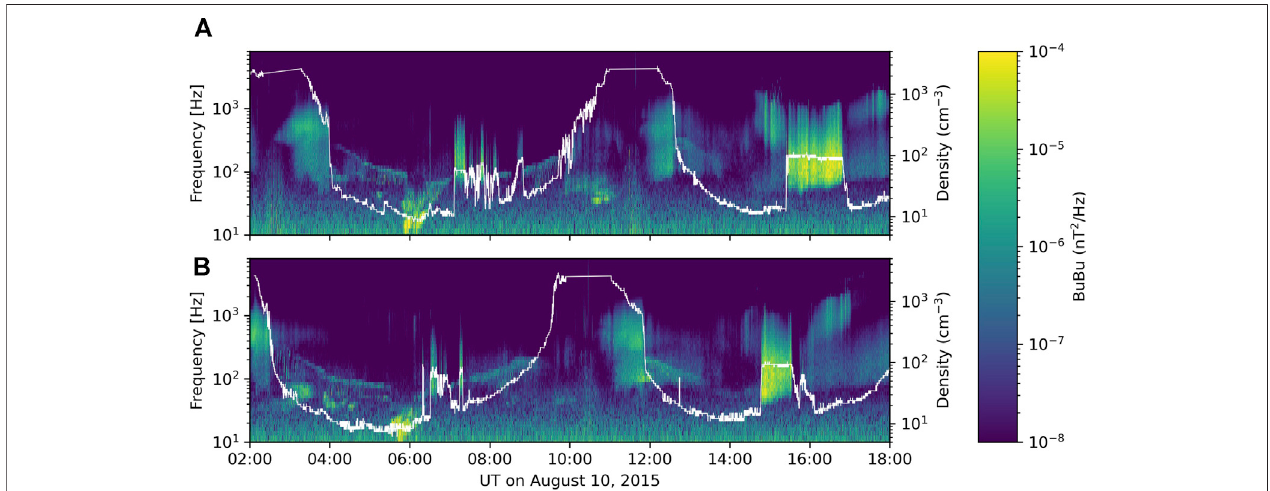
FIGURE 2 | RBSP-A (A) and RBSP-B (B) EMFISIS data on 10 August 2015. The spectrogram shows the WFR cross spectrum diagonal matrix element, BuBu (spacecraft spin plane component of magnetic fi eld), between 10 Hz and 8 kHz. Plasma density derived from the upper hybrid frequency is shown with the white trace.